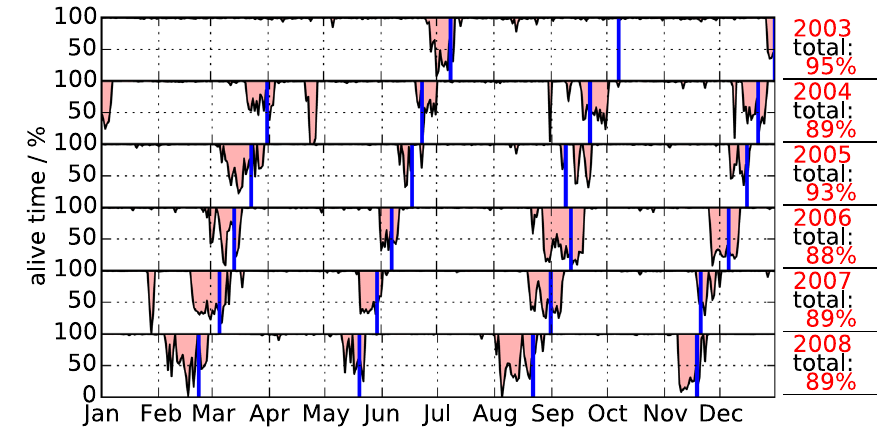
Fig. 2. Alive time of EPHIN over six years. The blue lines indicate the date of a SOHO roll